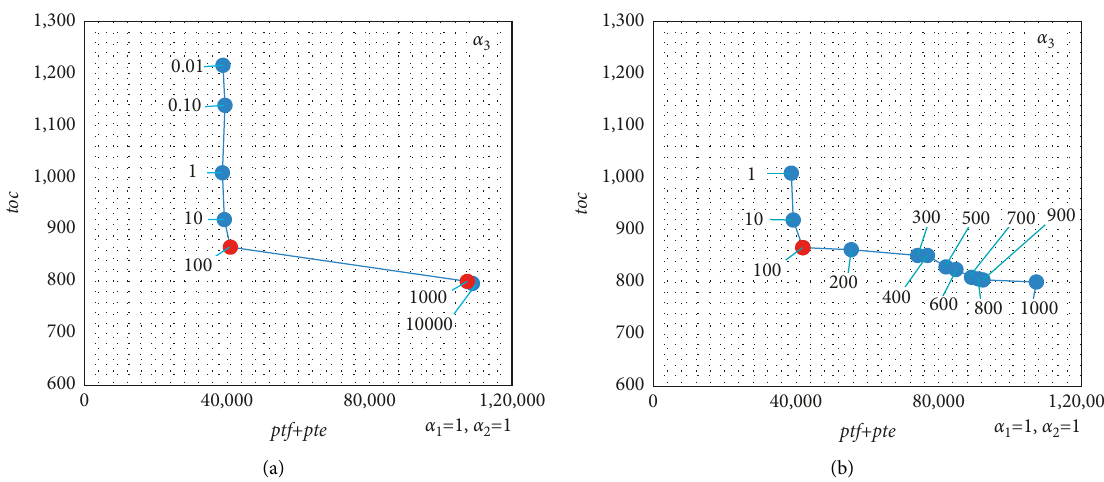
Figure 10: Pareto curve of results with different values of α